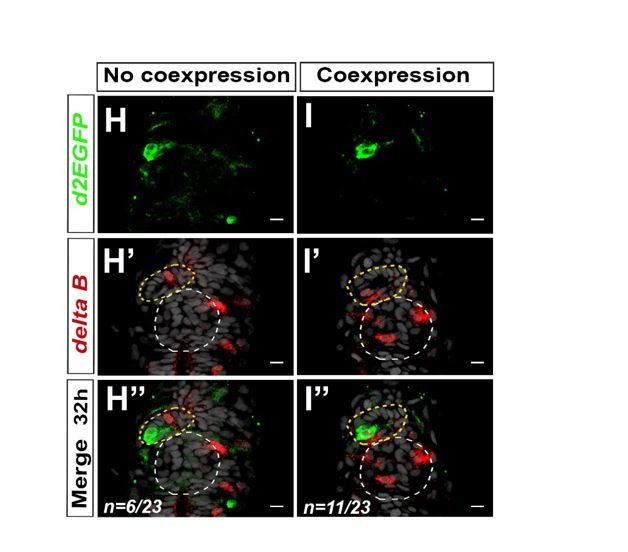
Notch ligand deltaB is mosaically expressed in the parapineal.(A-B’’) Confocal sections showing the expression of Tg(dusp6:d2EGFP) transgene (green, A, B) or deltaB (red, A’-B’) and merge (A’’-B’’) in the epithalamia of two representative embryos at 32 hpf. deltaB mRNA is detected in only one or two parapineal cells in most embryos (n=17/23); staining is either co-expressed with Tg(dusp6:d2EGFP) (n=11/23) or detected in Tg(dusp6:d2EGFP) negative cells (n=6/23); in n=6/23, deltaB was not detected in the parapineal. Embryo view is dorsal, anterior is up; epiphysis (white circle), parapineal gland (yellow circle); scale bar=10 µm. Data representative of 2 experiments.